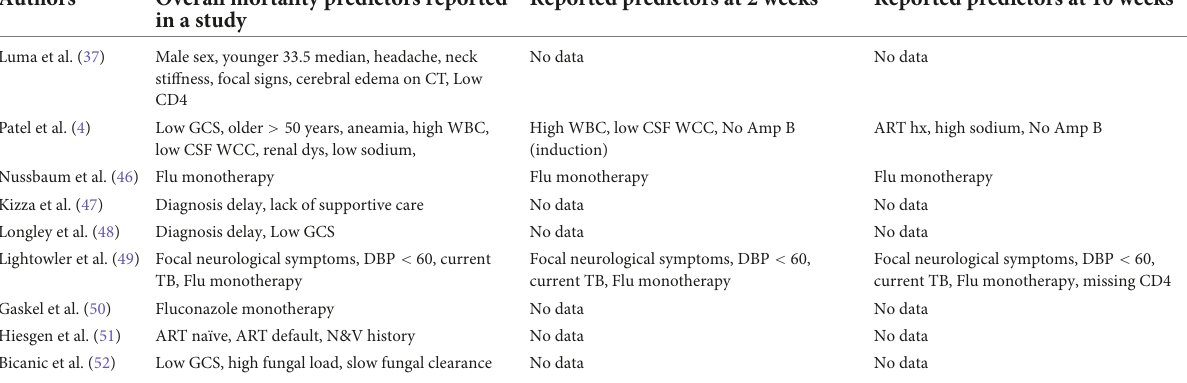
TABLE 4 Summary of reported predictors of mortality for HIV-related CM for each study included in the narrative synthesis.